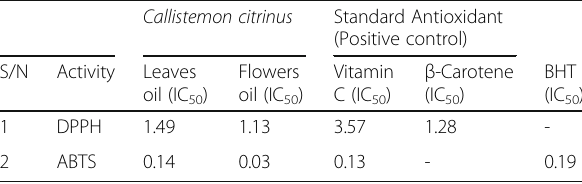
Table 4 IC 50 profile of the leaves and flowers oil of Callistemon citrinus (mgmL − 1